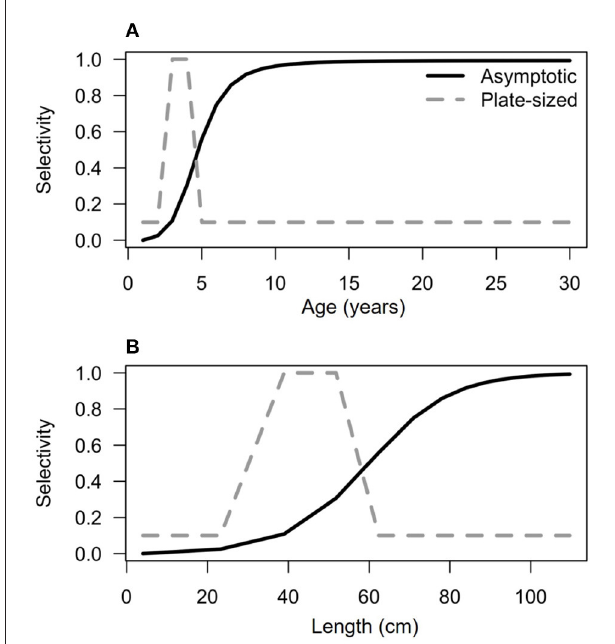
FIGURE 2 | Selectivity functions at age (A) and length (B) for bacalao (similar functions for PGG are not shown). Asymptotic selectivity (solid black line) has a greater probability of capturing individuals larger than 60 cm in total length. Plate-sized selectivity (dotted gray line) has a greater probability of targeting individuals between 25 and 60 cm in total